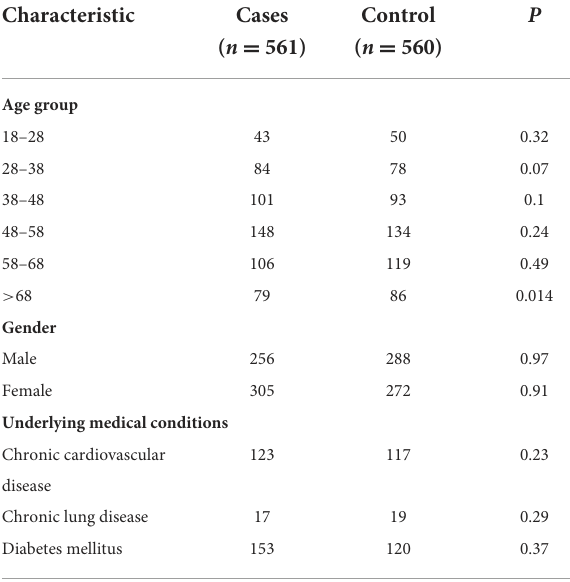
TABLE 1 Characteristics of Jordanian hospitalized COVID-19 case-patients and